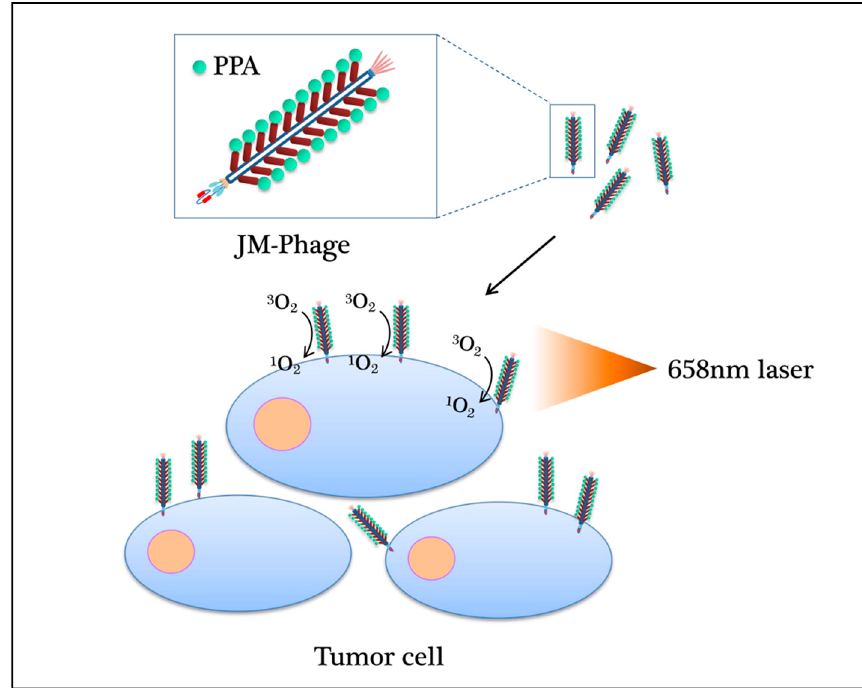
Figure 2. The mechanism of PDT phage photosensitizers for various cancers. PDT can be used to develop different types of phage photosensitizers. Whether in vivo or in vitro, these specific pho ‐ tosensitizers can effectively eliminate tumors by producing cytotoxic 1 O 2 by irradiation with light of the 658 nm wavelength at the target site. light of the 658 nm wavelength at the target